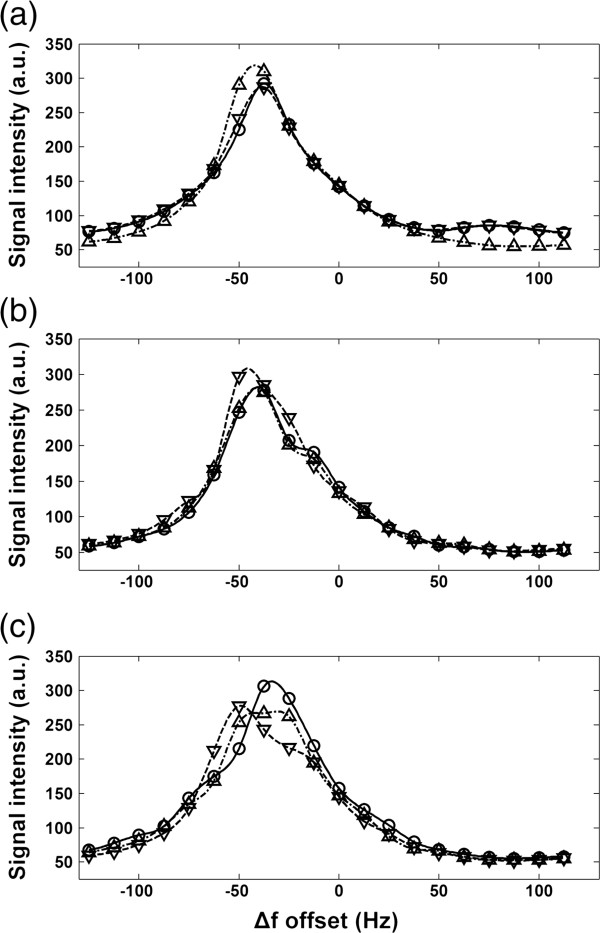
Typical 20-pt sweep scan curves obtained using bSSFP-L under three conditions (a) BH + ECG, (b) BH, (c) FB. For each condition, three repeated sweep scans were performed. From (a) to (c), the reproducibility appear progressively lower.